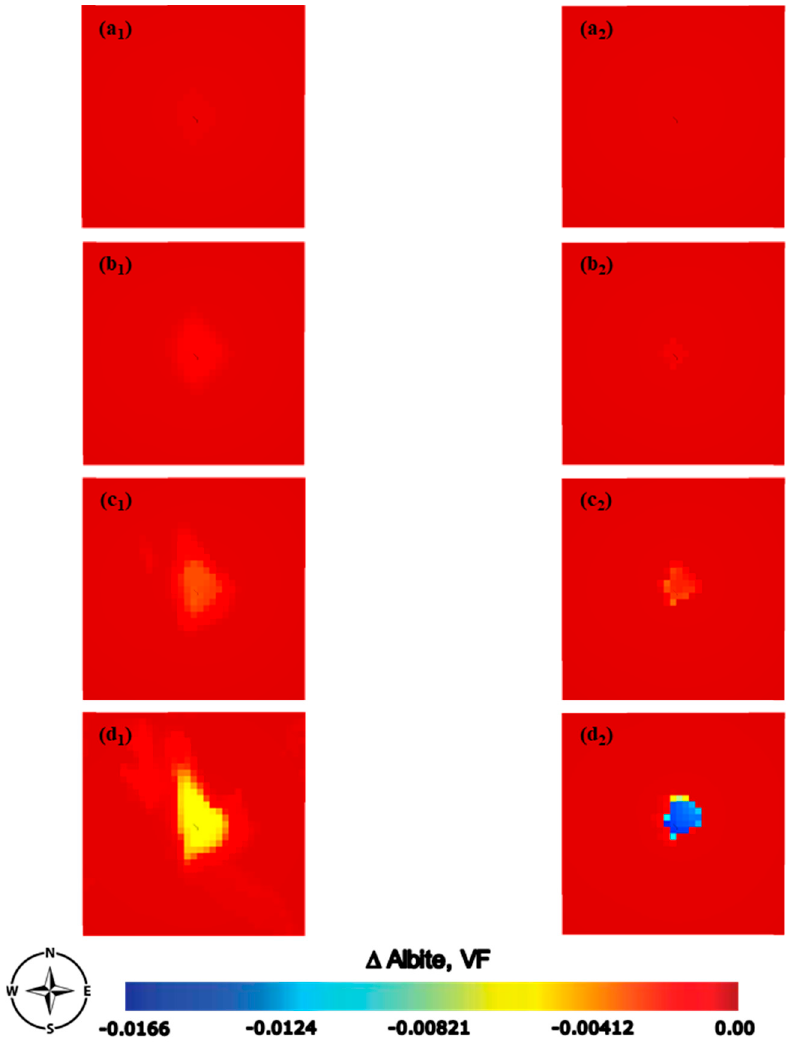
Figure 8. Plan view diagrams illustrating the simulated ∆ albite volume fraction evolution for the base case from the arkosic layer top view ( a 1 , b 1 , c 1 , d 1 ) and homogenous case from the Upper Mt. Simon top view ( a 2 , b 2 , c 2 , d 2 ) at ( a ) 30 years, ( b ) 100 years, ( c ) 1000 years, and ( d ) 10,000 years. Each figure’s size is 35 km × 35 km (x, y).